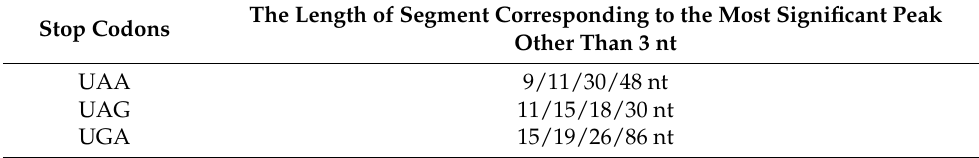
Table 1. Periodicity of the distribution of three stop